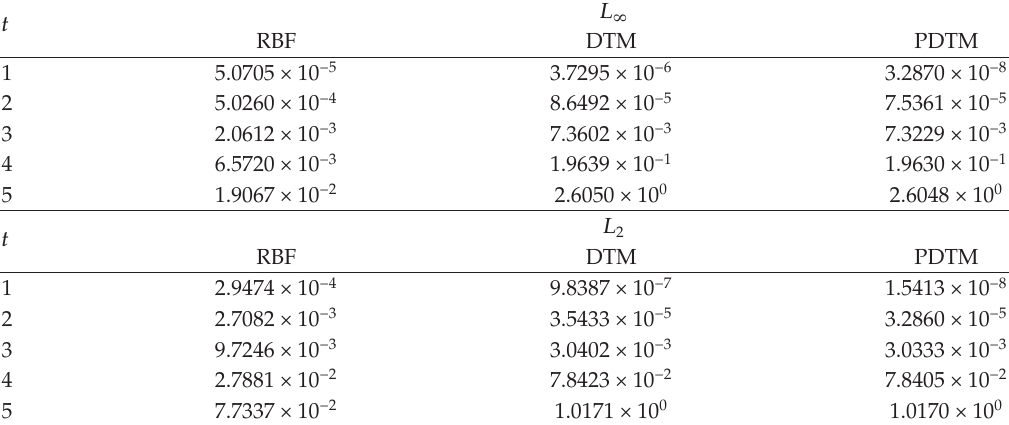
Table 3: Comparison for the L ∞ and L 2 error estimates of the approximate solutions obtained by RBF, DTM, and PDTM at each